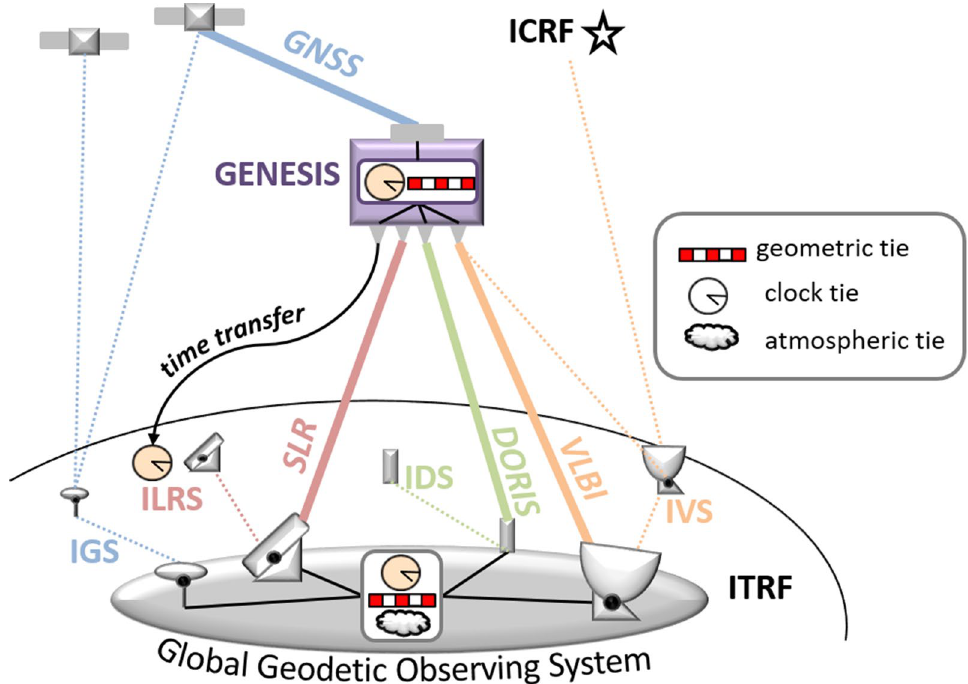
Fig. 2 The GENESIS mission will consist of the co‑location, for the first time ever, of the four space geodetic techniques (GNSS, SLR, VLBI, and DORIS) aboard a single well‑calibrated satellite in Medium‑Earth Orbit (MEO). This will result in a unique dynamic space geodetic observatory, which combined with the measurements of geodetic co‑location sites on the ground, shall allow obtaining a significant improvement of the